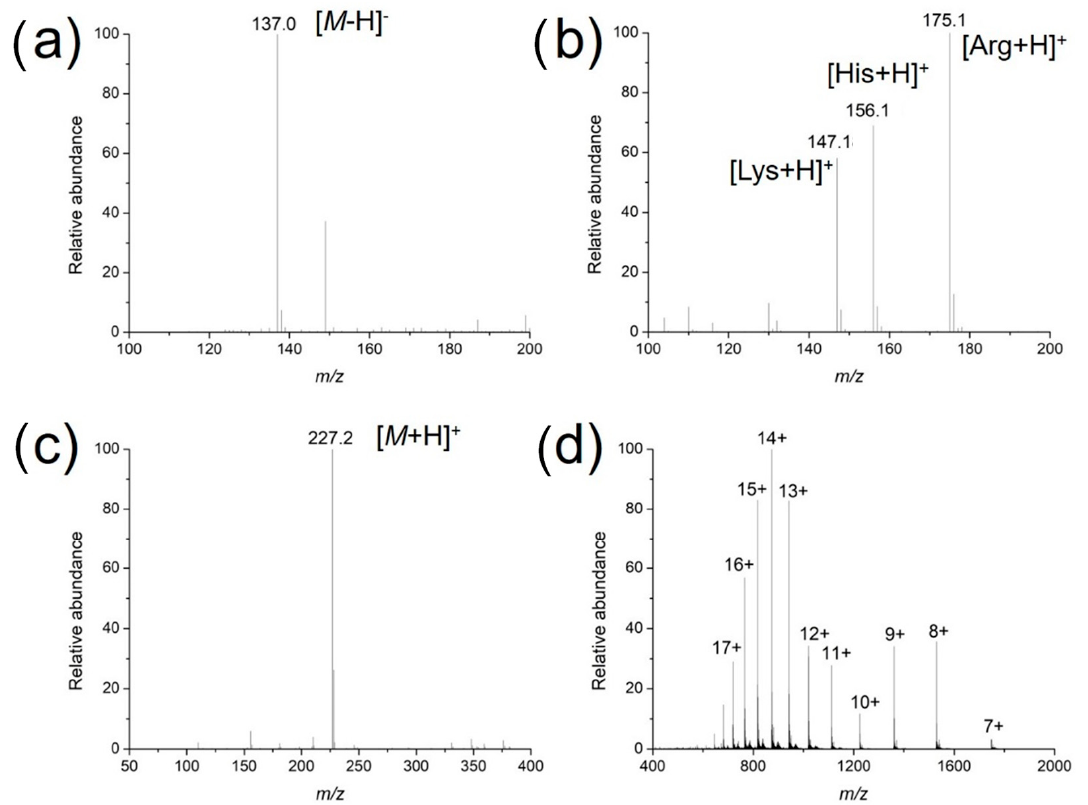
Figure 3. Mass spectra of different analytes ionized via surface-modified acupuncture needles: ( a ) An amount of 1 μ M salicylic acid in the negative ion mode; ( b ) a mixture of L-lysine, L-histidine and L-arginine at equimolar concentrations of 1 μ M; ( c ) 1 μ M L-carnosine; and ( d ) 10 μ M cytochrome c in the positive ion mode.